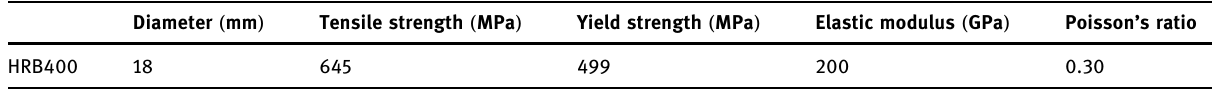
Table 2: Mechanical parameters of the steel